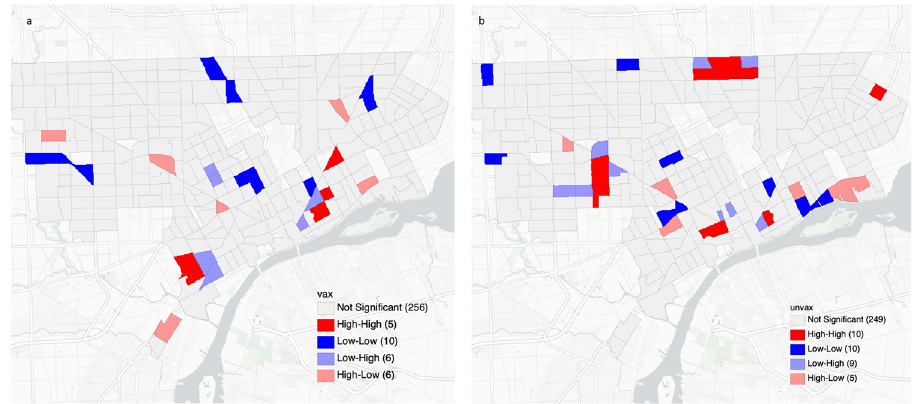
Fig 2. Hotspot clusters of vaccinated patients (a) and unvaccinated patients (b). Clusters are categorized as high-high cluster (red), low-low cluster (blue), low-high outlier (light blue), and high-low outlier (light red).